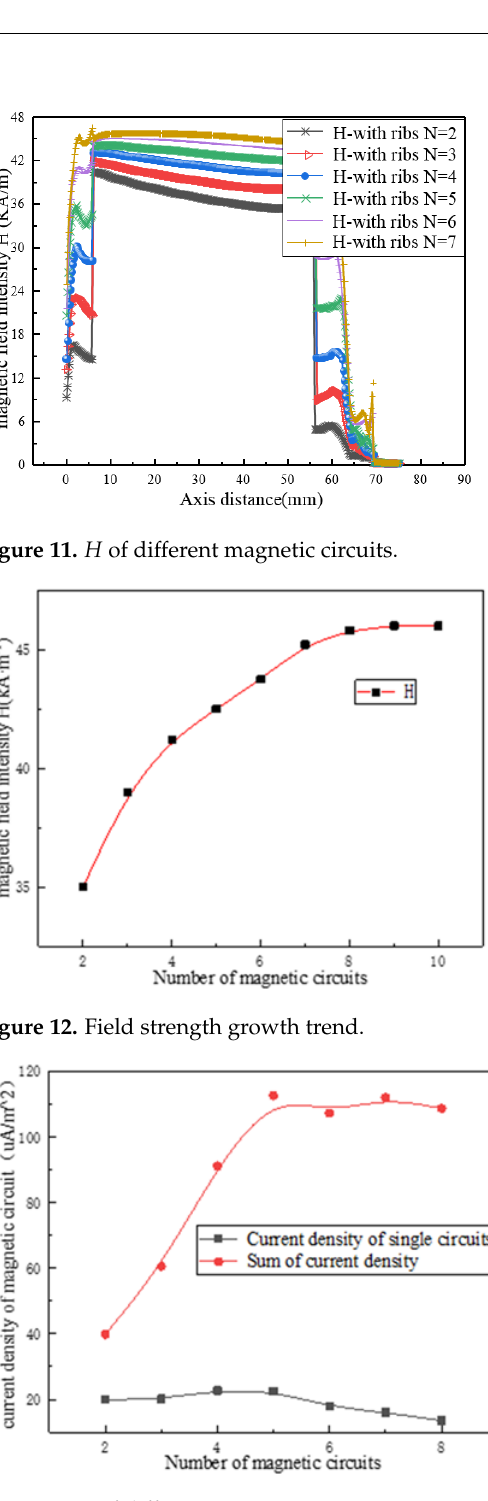
Figure 13. J of different circuits.